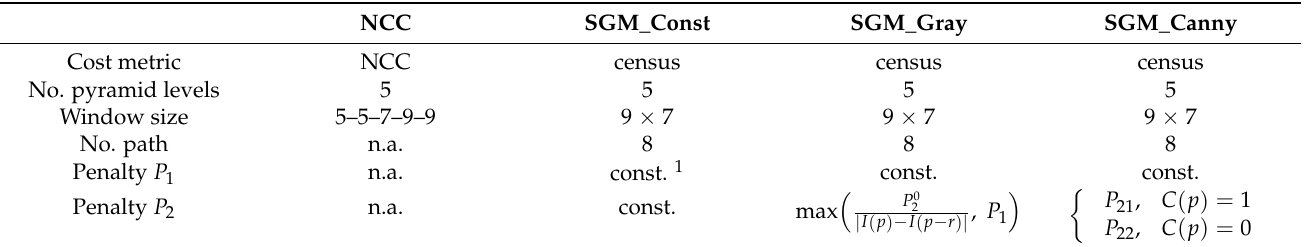
Table 2. Main parameters used in applied matching